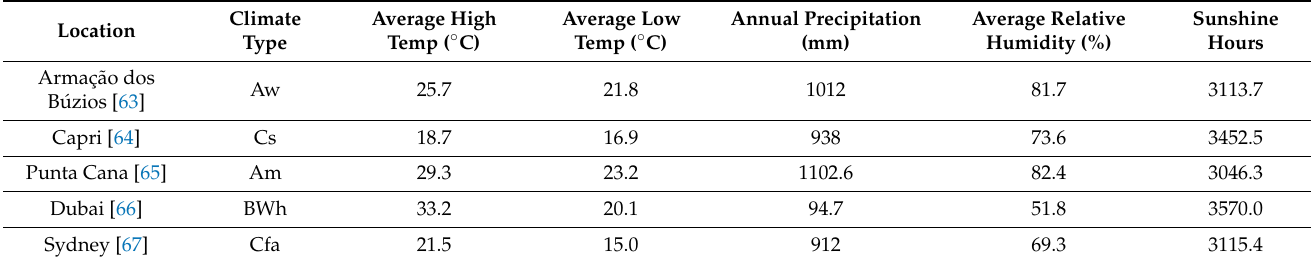
Table 7. Climatic conditions for selected